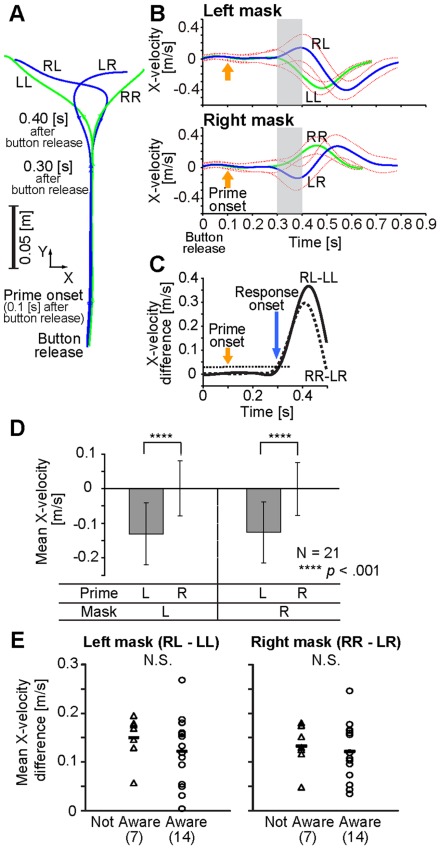
Kinematic properties of reaching movement.(A) Average reach trajectory to the far target of each side in each condition for a single participant. Green and blue curves show trajectories when prime-mask combinations were congruent (RR and LL conditions) and incongruent (LR and RL conditions), respectively. (B) Average X velocity profile in each far-target condition for a single participant. Green and blue curves show the velocities when the prime-mask combination was congruent and incongruent, respectively. Red dashed curves denote ±1 SD of velocities between trials. The data were aligned at the button release. (C) Mean X velocity difference profiles (Solid: RL – LL. Dashed: RR – LR.) calculated from the pooled data to far and near targets. The velocity difference was calculated as the index of the response onset to the prime stimulus. The threshold value (dotted line) was set at 0.03 m/s. (D) Mean X velocity of the 100-ms-time window (calculated from the pooled data to far and near targets) corresponding to the gray area in Fig. 3B (i.e., 200∼300 ms after the prime onset) in each condition. (E) Relationship between the awareness of the association (between the participant’s own performance and the color cue) and the strength of the implicit motor control induced by the invisible stimulus. The difference of mean X velocity in the 100-ms-time window (Fig. 3D) between RL (RR) and LL (LR) conditions for each participant was calculated as the individual strength of the implicit motor control.